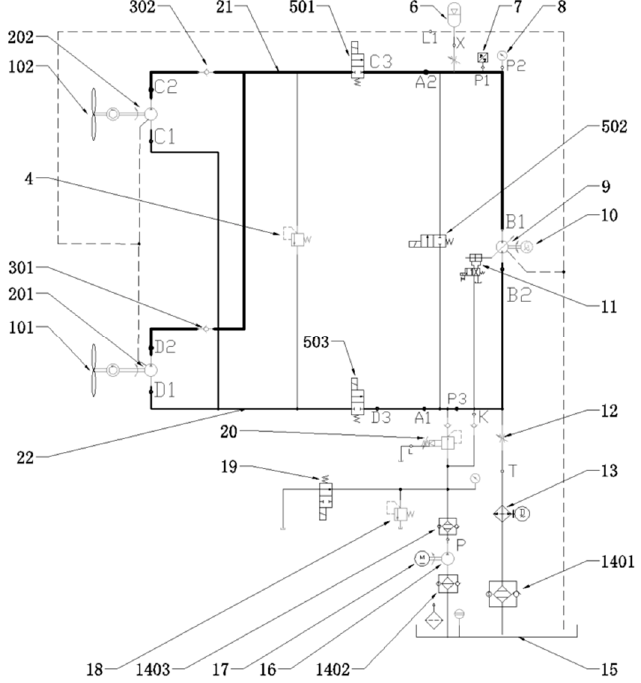
Figure 8. Hydraulic schematic of HAMCT. 101,102—rotors; 201,202—fixed displacement pumps; Figure